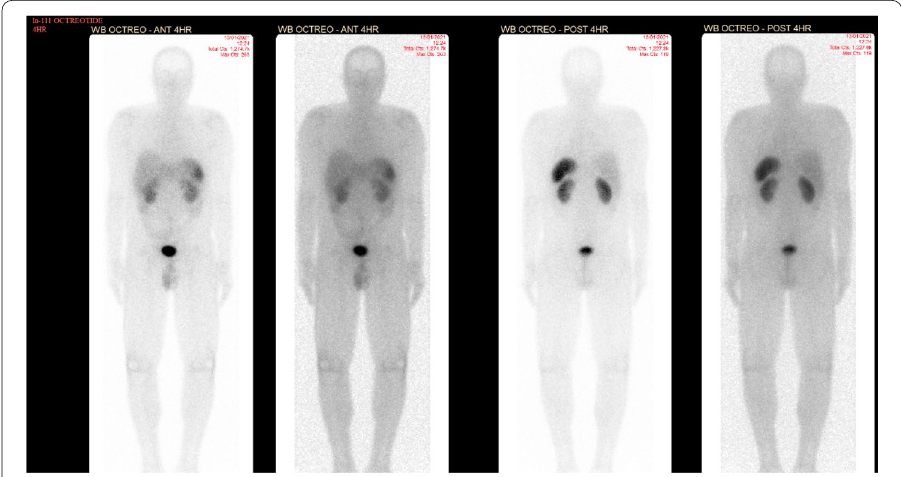
Fig. 1 Planar anterior and posterior whole-body 111In-pentetreotide imaging acquired at 4 h and 24 h demonstrating no pentetreotide-avid